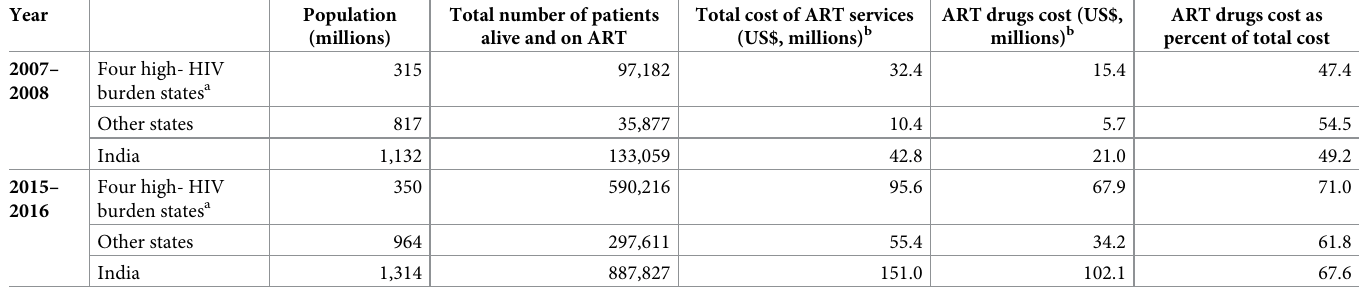
Table 4. Estimated cost of first-line ART in public sector ART centres in the four high-HIV burden states and the other states in India in fiscal years 2007–2008 and